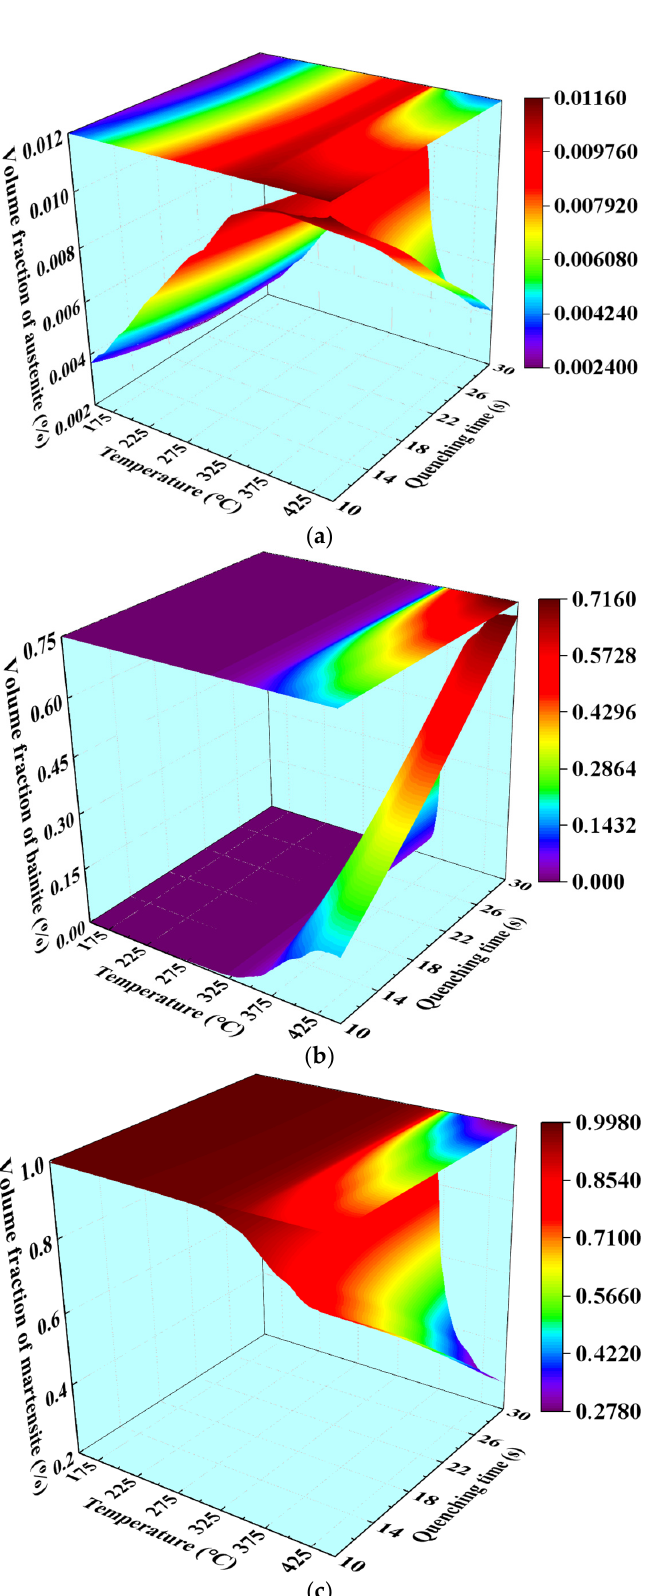
Figure 11. Three-dimensional mapping surfaces of ( a ) austenite, ( b ) bainite, and ( c ) martensite, with quenching time and the temperature of the